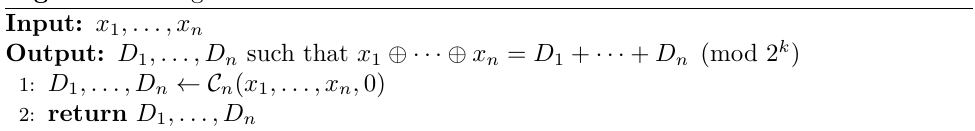
Algorithm 1 High-order Boolean to Arithmetic Conversion